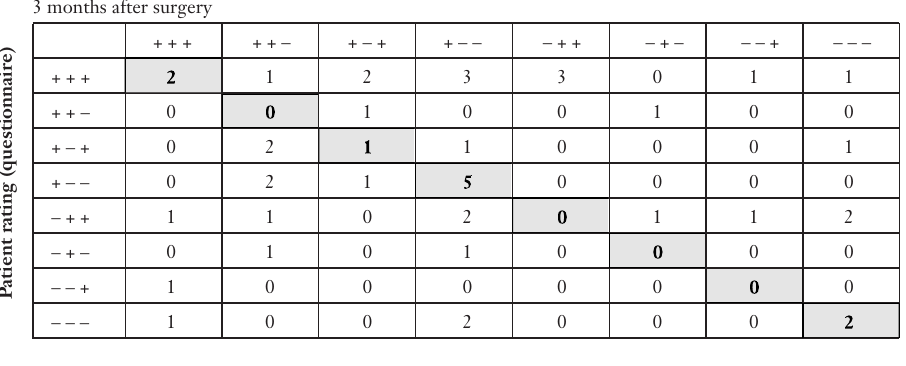
Table 1 Individual concor- dance data between physician rating (by chart) (columns) and patient rating (by questionnaire) (rows). “+” = present, “–” = absent.The first position corresponds to back- and buttock pain, the second to leg pain, and the third to neurological symptoms. Numbers are number of patients per category (total n = 44) per timepoint, i.e., pre- surgery baseline, 3 and 12 months post-surgery. “Total agreement” cells are